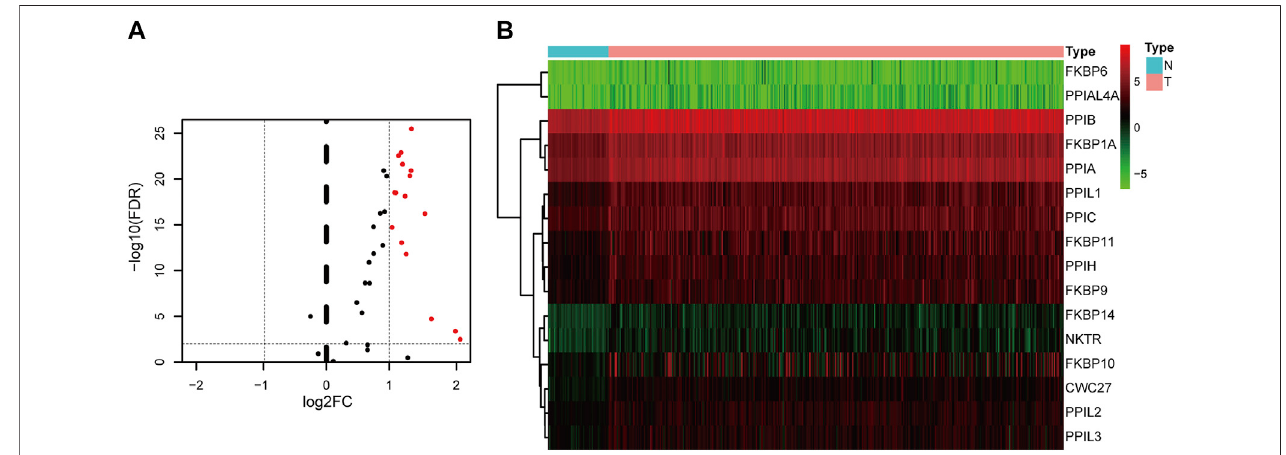
FIGURE 2 | Differentially expressed PPIase genes. Volcano plot (A) and heat map (B) of differential expression in hepatocellular carcinoma and para-cancerous tissues.